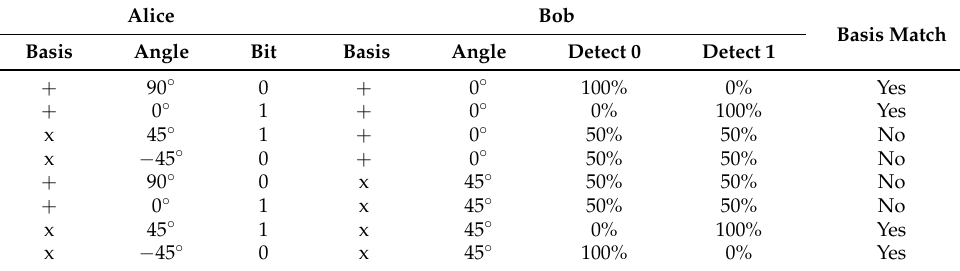
Table 2. Different cases for the basis and bits between Alice and Bob. See text for